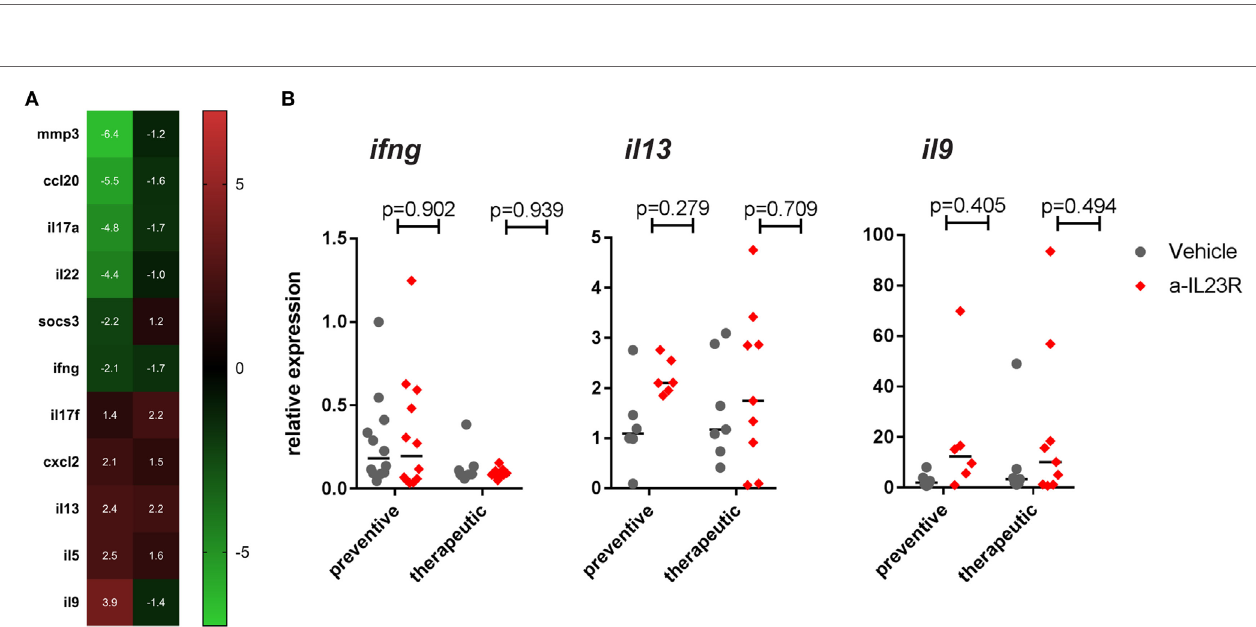
FigUre 5 | Therapeutic treatment with anti-IL23R, effect on downstream molecules in draining lymph nodes. (a) IL-17A, IL-22, and IL-17F gene expression directly ex vivo , (B) IL-17A protein in draining lymph nodes in unstimulated (medium only) versus stimulated (PMA/ionomycin) condition in vehicles and aIL23R treated rats and the ratio between the two groups (individual data points and median are depicted).